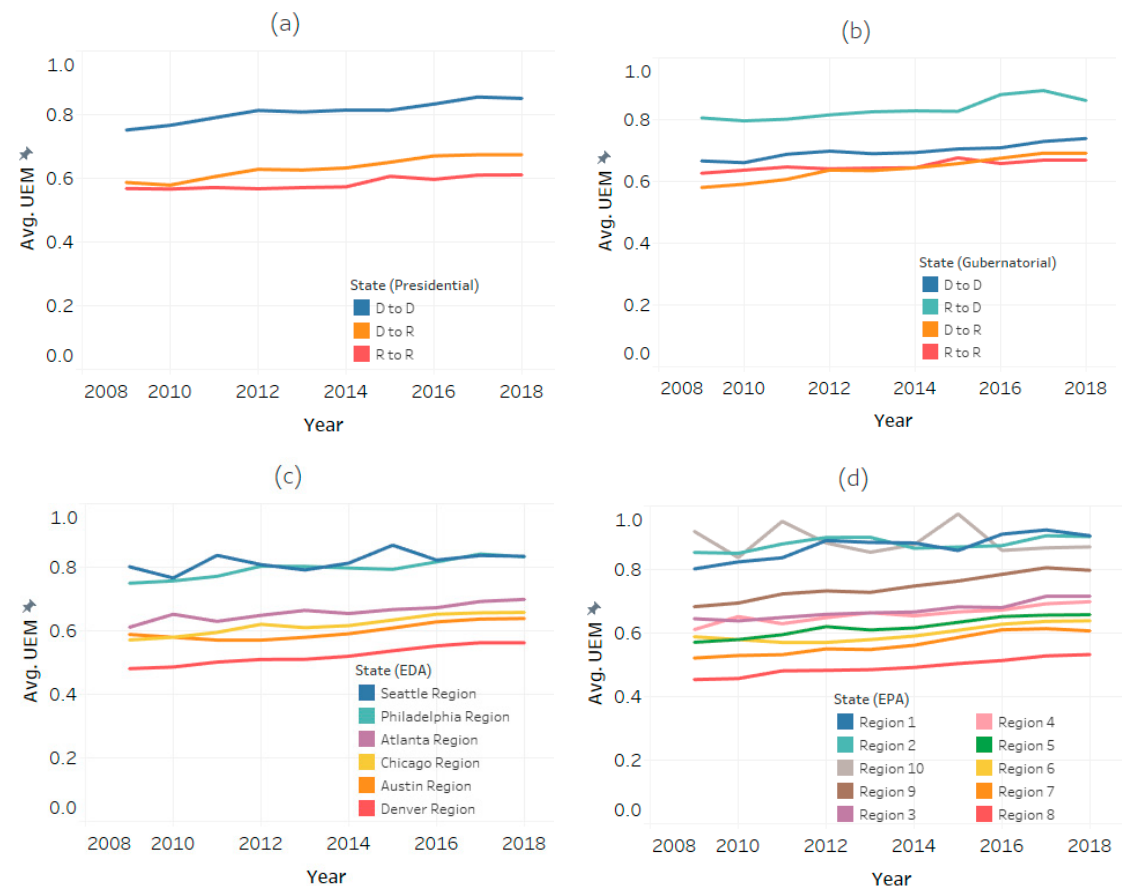
Figure 4. UEM Scores over Time by States ( a ) with History of Presidential Elections Transitioning from the Democratic to the Democratic (D to D, Blue-Colored), from the Democratic to the Republican (D to R, Orange-Colored), and from the Republican to the Republican (R to R, Red-Colored), ( b ) with History of Gubernatorial Elections Transitioning D to D (Blue-Colored), R to D (Cyan-Colored), D to R (Orange-Colored), and R to R (Red-Colored), ( c ) of EDA’s Six Different Regions, and ( d ) of EPA’s Ten Different Regions.